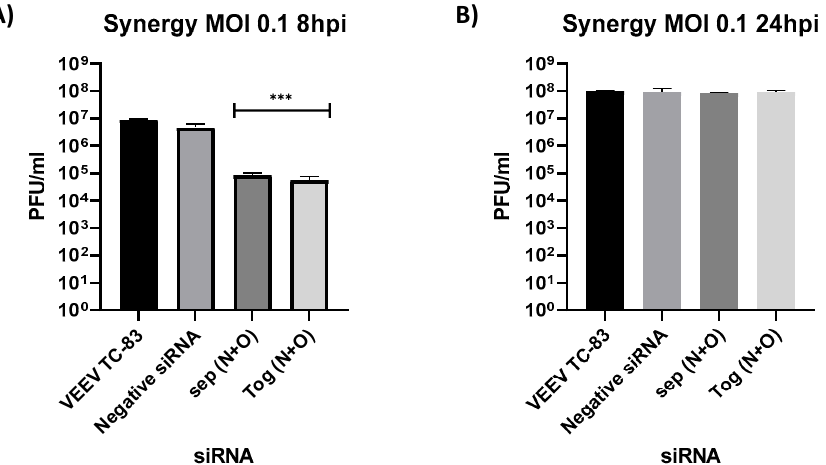
Figure 5. Impact of siRNA combinations on antiviral efficacy. ( A , B ) 293T cells transfected with siRNA N and siRNA O either by mixing them together (N + O) or by separate (N + O). ( A ) Both siRNAs were mixed in the same tube with the DharmaFECT1 reagent and then added dropwise on the cells. ( B ) Both siRNAs were mixed in separate tubes with DharmaFECT1 reagent and then added dropwise on the cells. At 24 h post transfection, cells were infected with VEEV TC-83 at MOI of 0.1 and supernatants were collected at 8 and 24 hpi. Viral titers were determined via plaque assay. Graphs are representative of two independent experiment ( n = 6). *** p < 0.0002 compared to negative control siRNA.